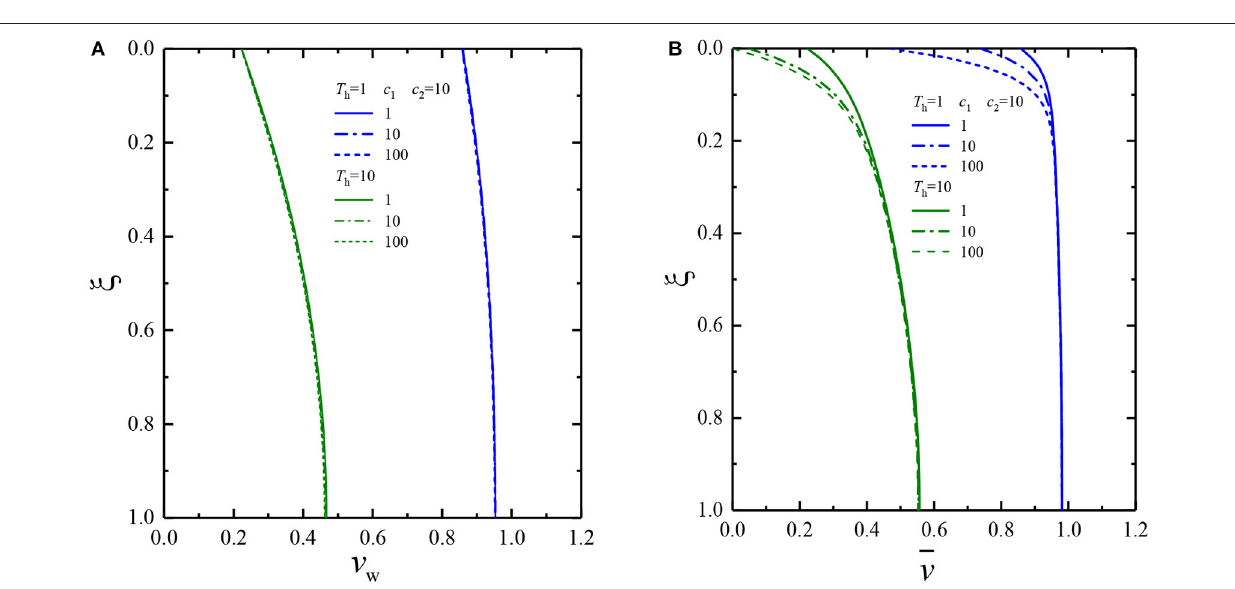
FIGURE 9 | Dissipation of pore-water pressure at any depth when c 2 soil